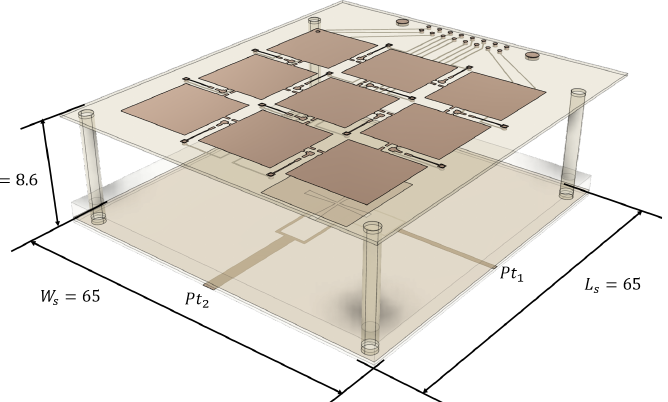
Figure 1. Exploded view of the Parasitic-Layer-based Reconfigurable-antenna used as case study. (Units in